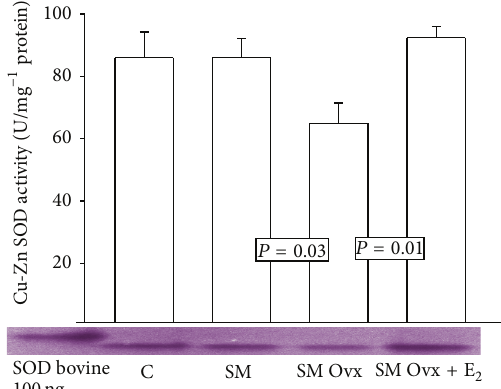
Figure 3: Cu-Zn SOD activity in adipocyte homogenate of exper- imental groups. Cu-Zn SOD: superoxide dismutase copper-zinc. Data are means ± SE; 𝑛 = 8 in each group.